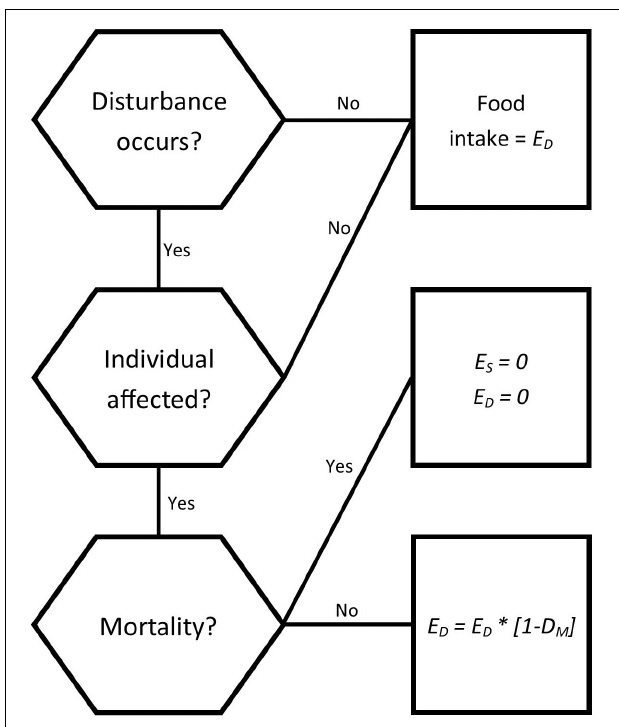
FIGURE 3 | Decision tree for how individuals are impacted by a disturbance for each time step (1 day). Disturbances influence the daily energy intake ( E D ) of an individual that is affected, while influencing both the energy intake and energy store ( E S ) of individuals who die as a result of